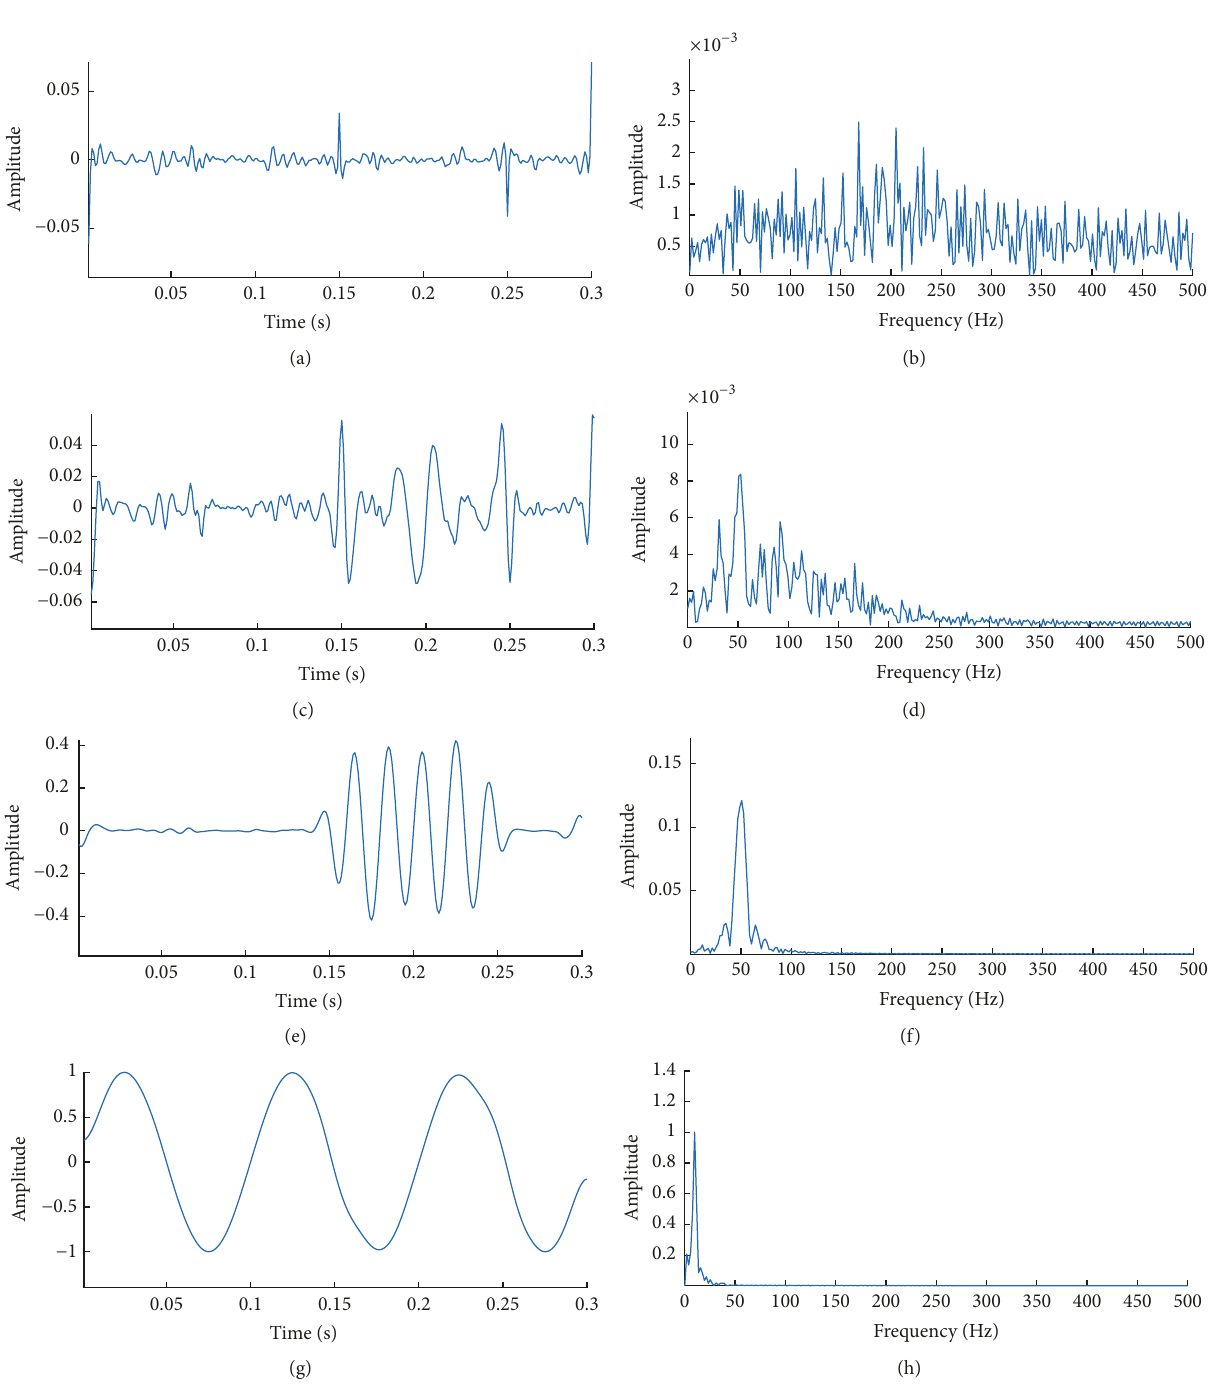
Figure 3: IMF and spectrum after the decomposition of the vibration signal with ICEEMD: (a, c, e, and g) IMF1 ∼ IMF4; (b, d, f, and h) IMF4